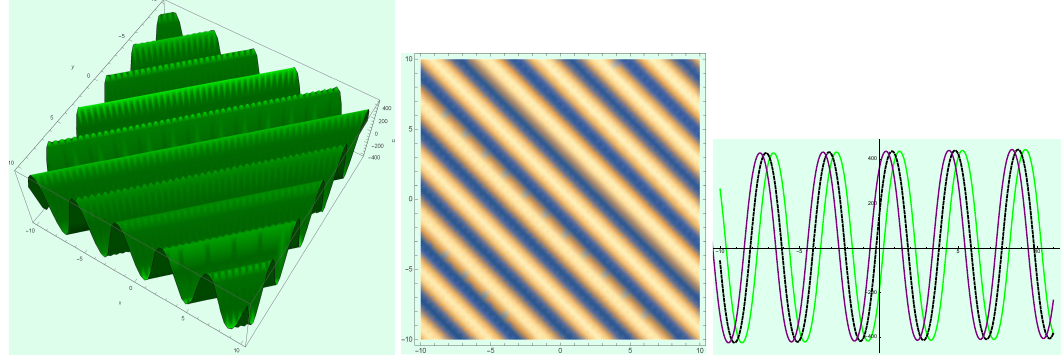
Figure 3. Evolution of periodic solution (20) at t = − 25 and z = −